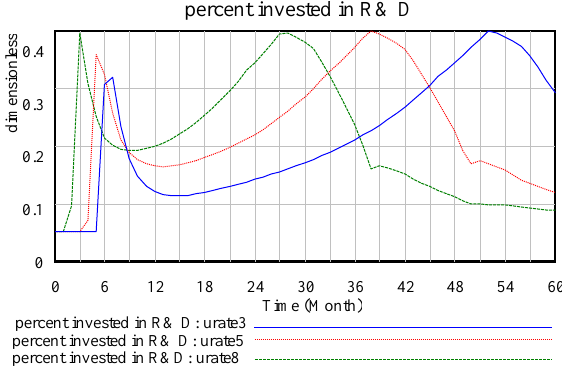
Figure 16. Percent invested in R&D.